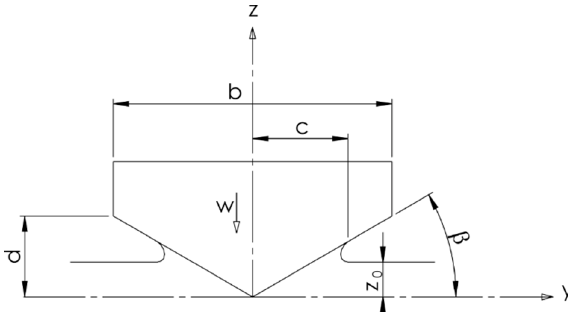
Figure 1. Impact with symmetry entry.